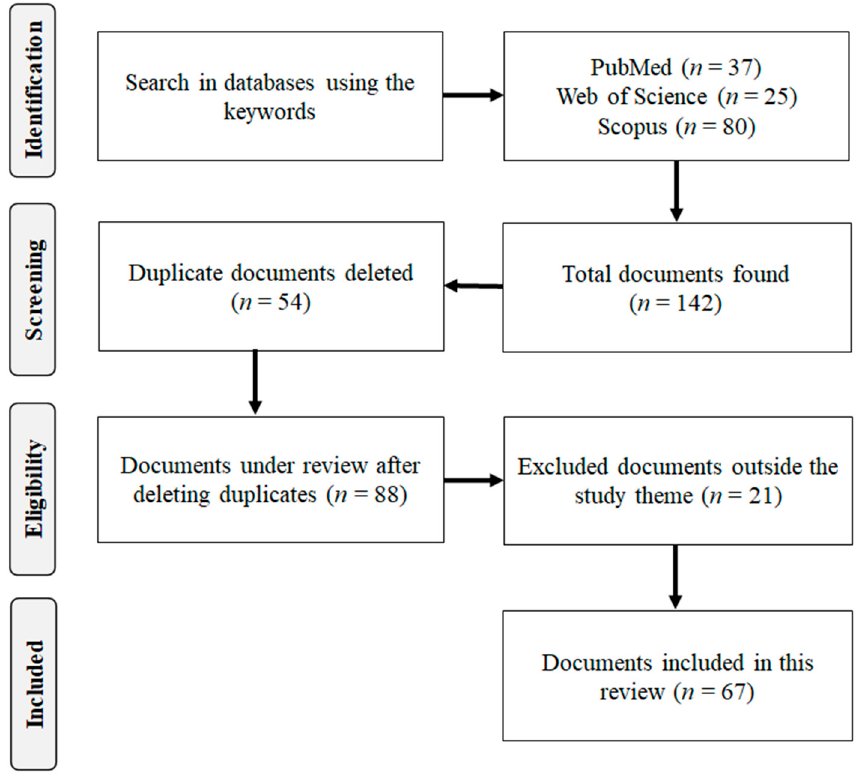
Figure 2. Selection flowchart of scientific documents included in this review.